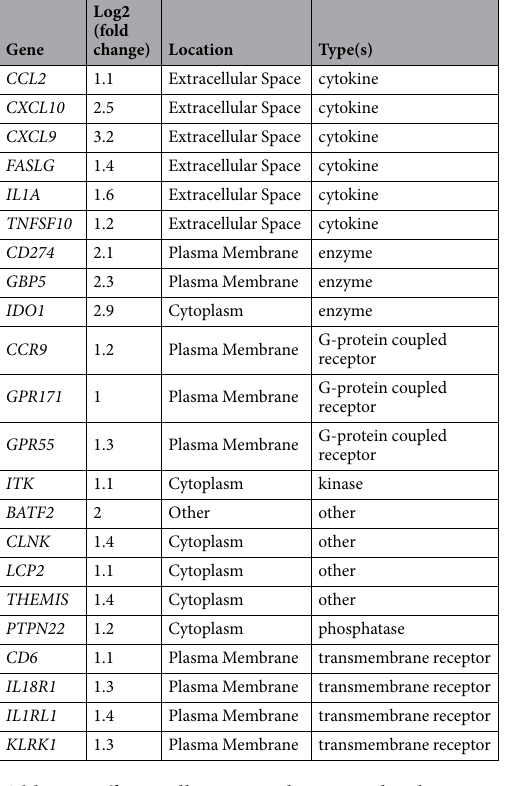
Table 2. Differentially expressed genes in distal jejunum enriched for GO terms that are associated with immune functions.